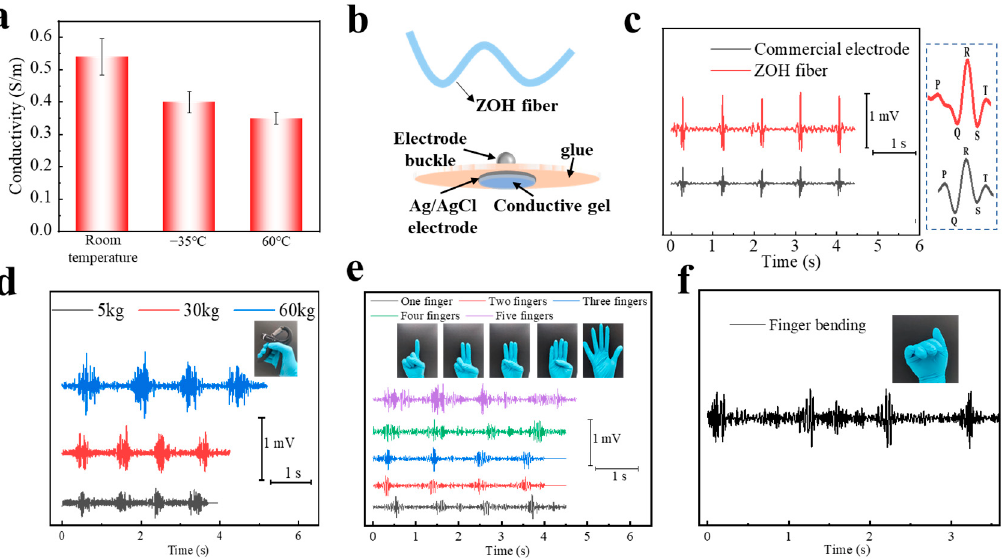
Figure 4. ( a ) Conductivity of the ZOH fiber at room temperature, − 35 ◦ C, and 60 ◦ C. ( b ) Structure differences between ZOH fiber-based electrodes and commercial electrodes. ( c ) A comparison of ECG measurement results of commercial electrodes and ZOH fiber-based electrodes. The dashed frame shows the waveform of a single ECG signal. ( d ) EMG signals of varying gripping force detected by ZOH fiber-based electrodes. ( e ) EMG signals of different numbers of fingers extensions detected by ZOH fiber-based electrodes. ( f ) EMG signal of a knee bend detected by ZOH fiber-based electrodes. It can be seen that the ECG signal peak measured by ZOH fiber-based